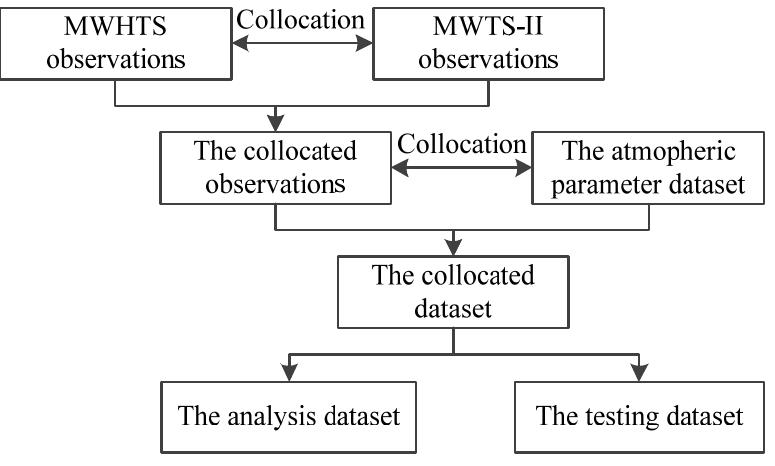
Figure 2. The schematic of the data pre-processing procedures.